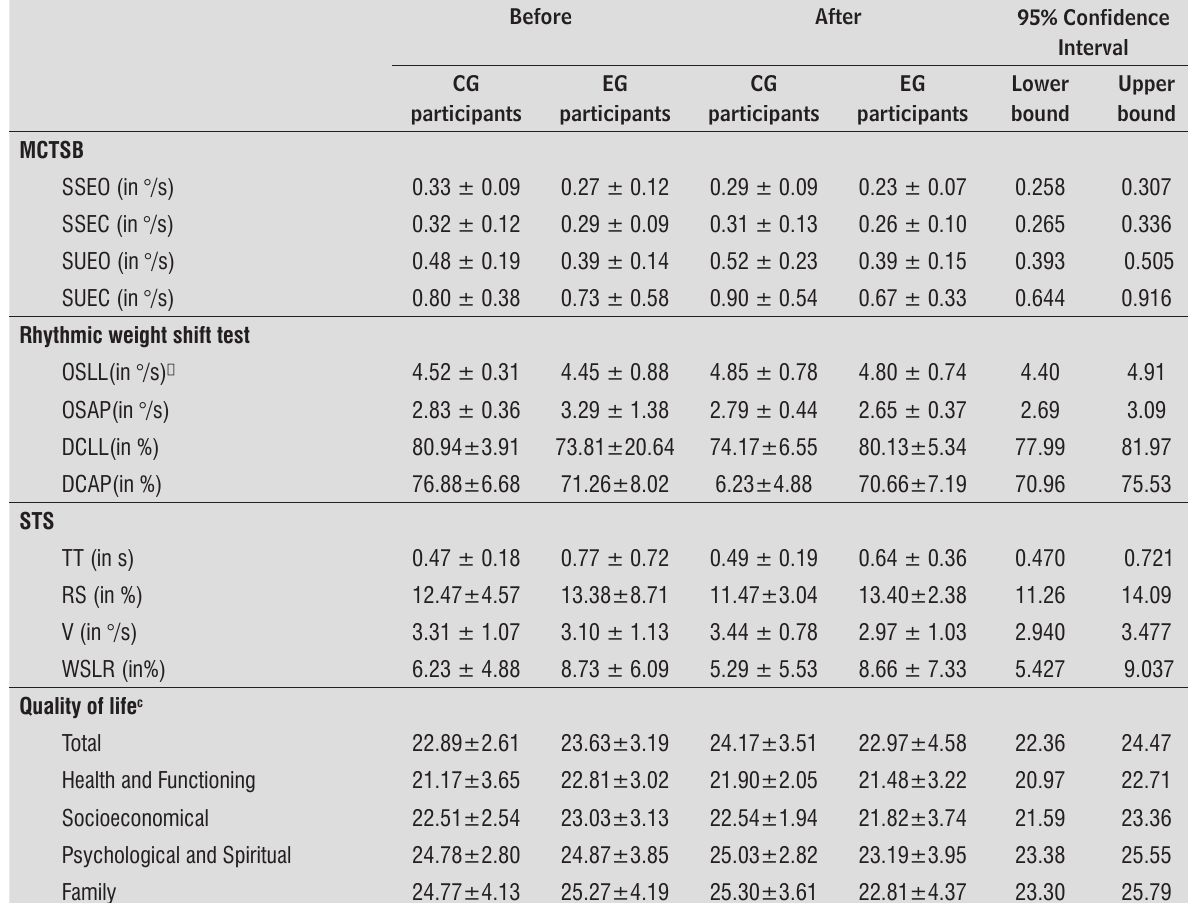
Table 2 - Intra and inter-group interaction analysis of postural balance and quality of life variables between initial and final assessment conditions